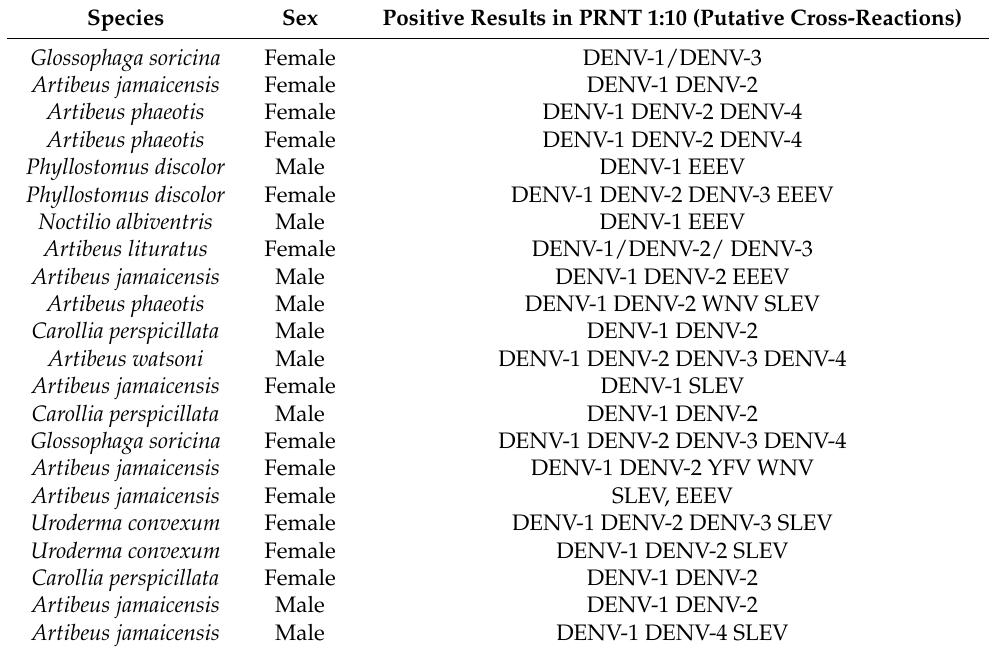
Table 1. Species of bats presenting serological cross-reaction among viruses ( Flaviviruses and Al- phaviruses ) were analyzed in the PRNT 1:10